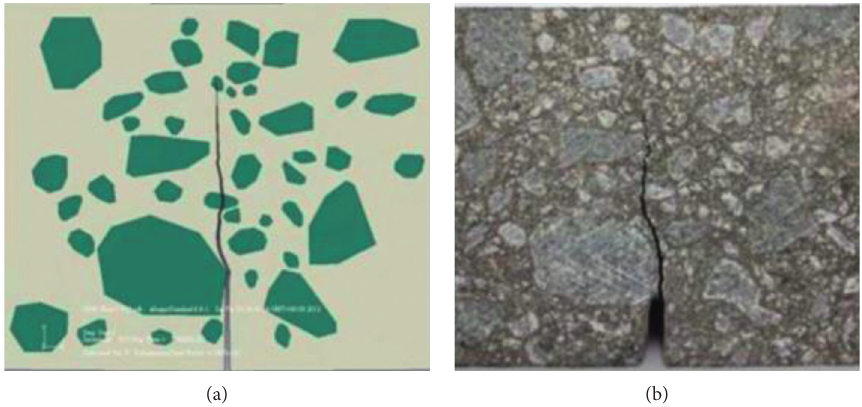
Figure 36: Comparison of cracking path in numerical simulation (a) and bending beam (b)